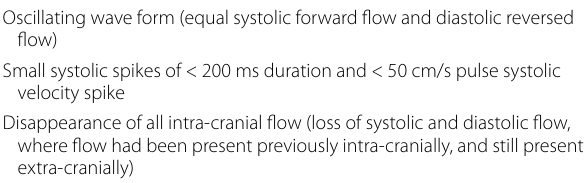
Table 2 Cerebral circulatory arrest criteria by transcranial Doppler Oscillating wave form (equal systolic forward flow and diastolic reversed flow) Small systolic spikes of < 200 ms duration and < 50 cm/s pulse systolic velocity spike Disappearance of all intra-cranial flow (loss of systolic and diastolic flow, where flow had been present previously intra-cranially, and still present